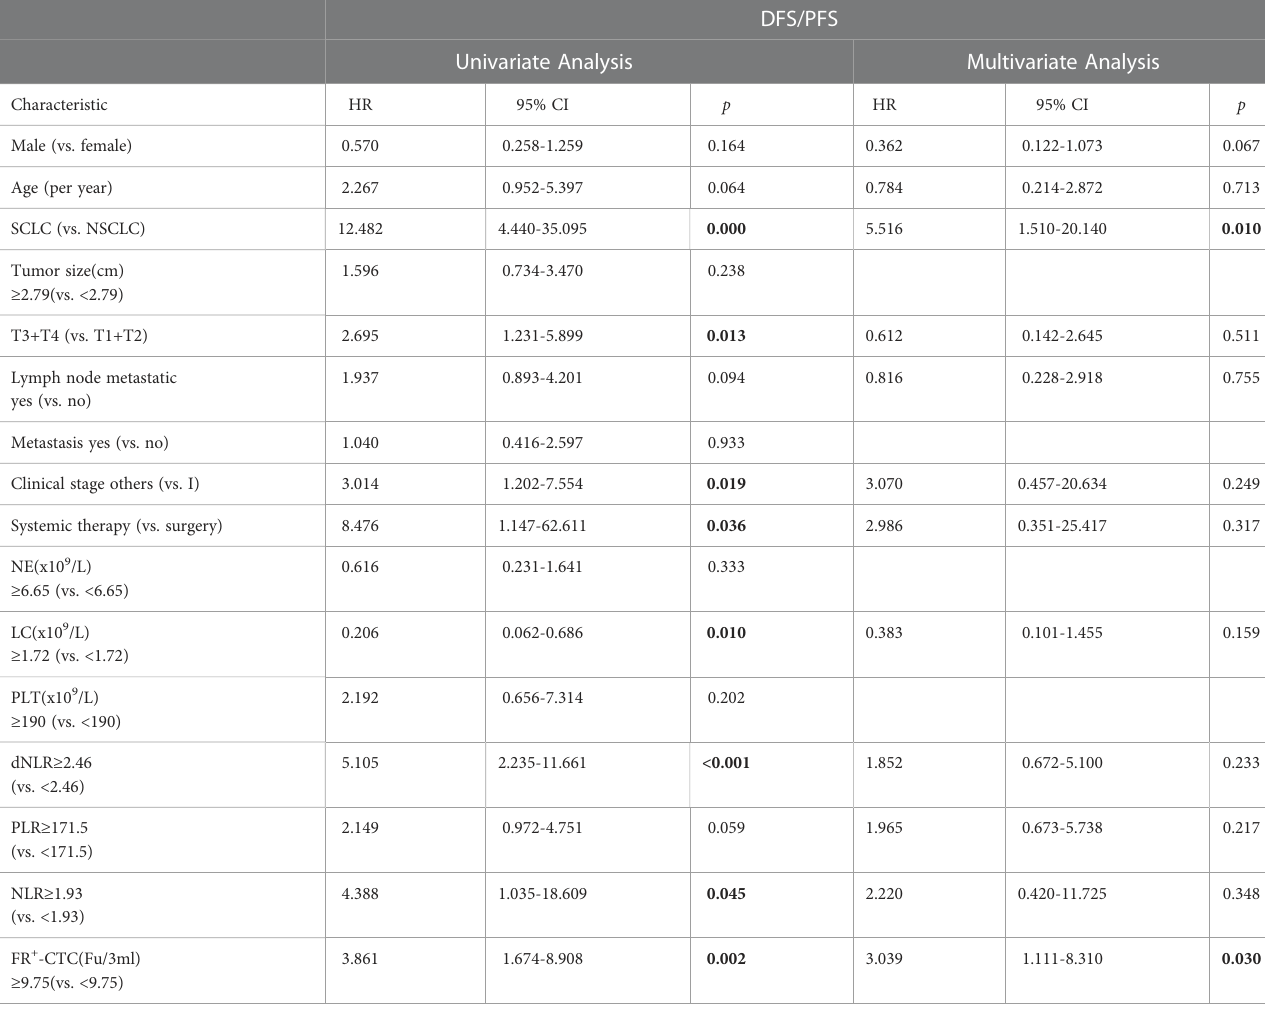
TABLE 3 Univariate and multivariate analyses of disease- or progression-free survival (N = 68, 26 progression